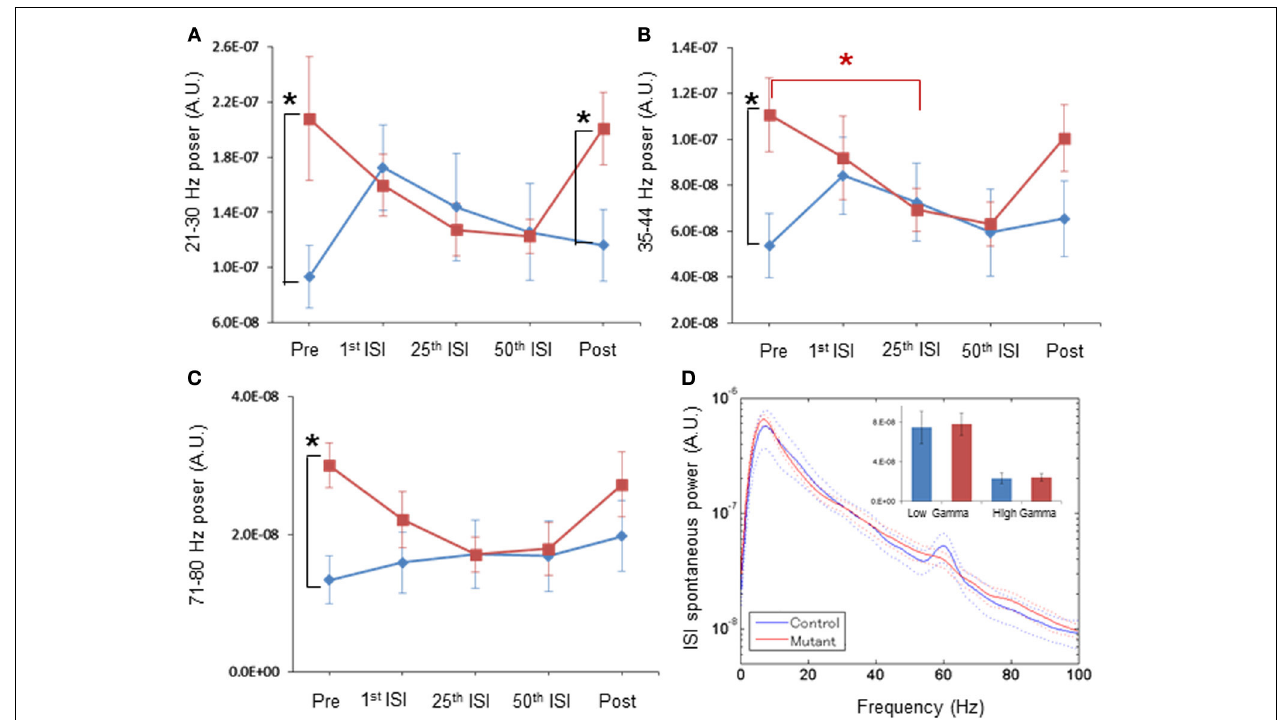
and mutant (red) mice. ∗ p < 0 . 05. Repeated-measures ANOVA followed by post-hoc Bonferroni testing. (D) No differences in averaged spontaneous LFP power amplitudes in the first, the 25th and the 50th ISIs, across frequencies between control (blue, n = 7) and mutant (red, n = 6) mice. The inset shows no difference in average LFP power amplitudes at low gamma (30–50Hz) and high gamma (50–100Hz) frequency. A 60-Hz bump in control LFP power spectra was due to power line noise contamination. Dotted lines: mean ±